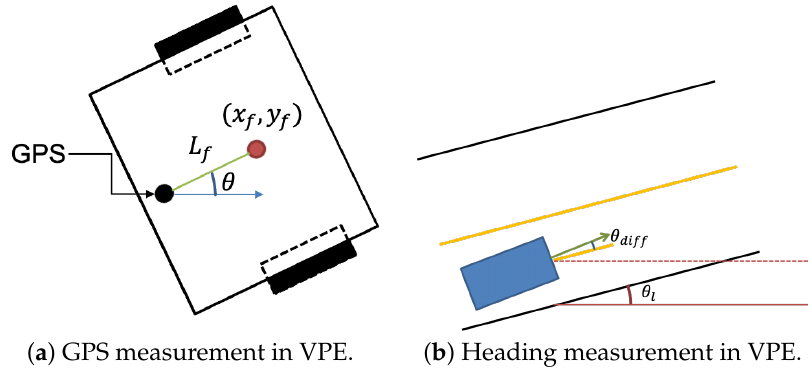
Figure 12. Measurements in